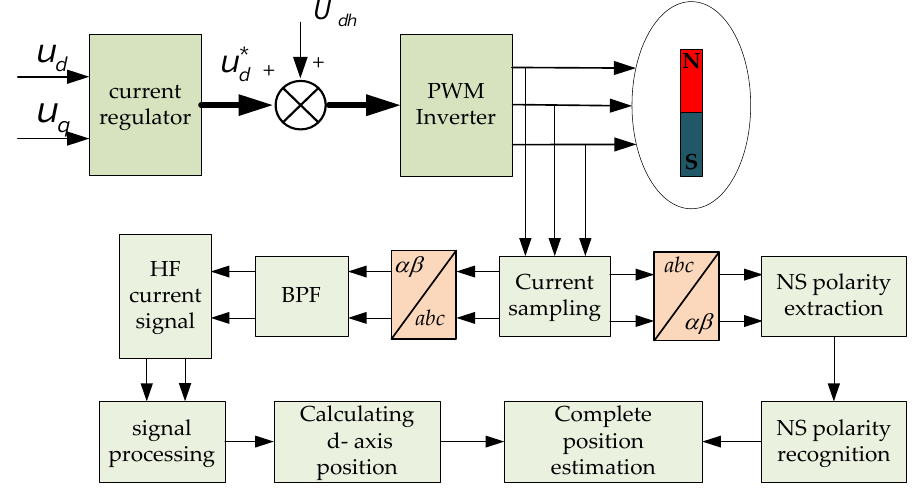
Figure 3. Block Diagram of the Square Wave HF injection method.